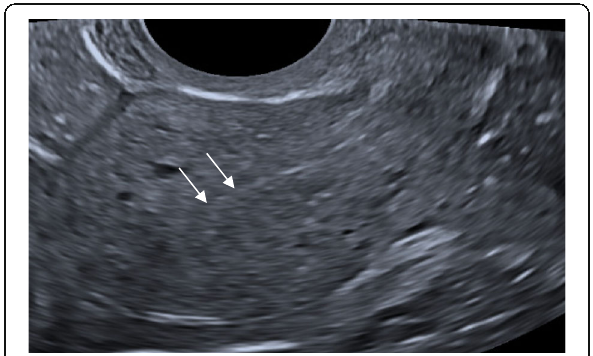
Fig. 5 Sagittal view by TVUS showing a thin echogenic line (white arrow), 3 mm surrounded by hypoechoic halo. Histopathology result of the endometrial biopsy was consistent with endometrial atrophy